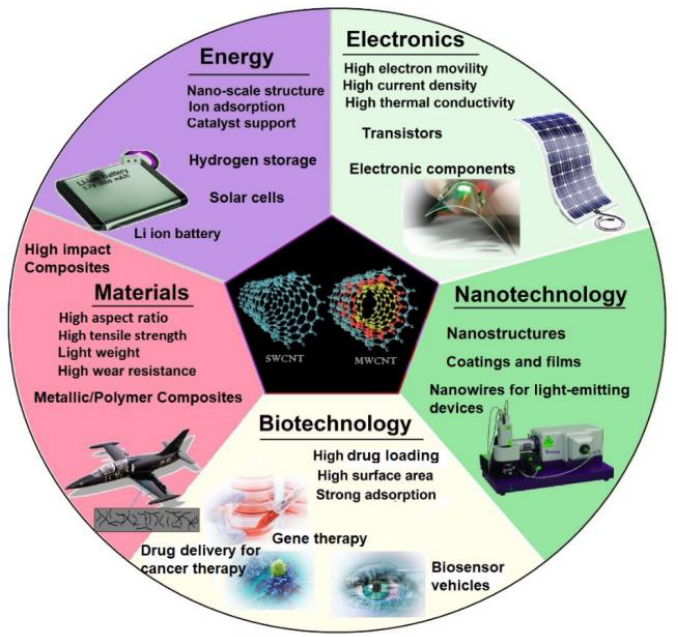
Figure 1. Schematic representation of properties and applications of carbon nanotubes